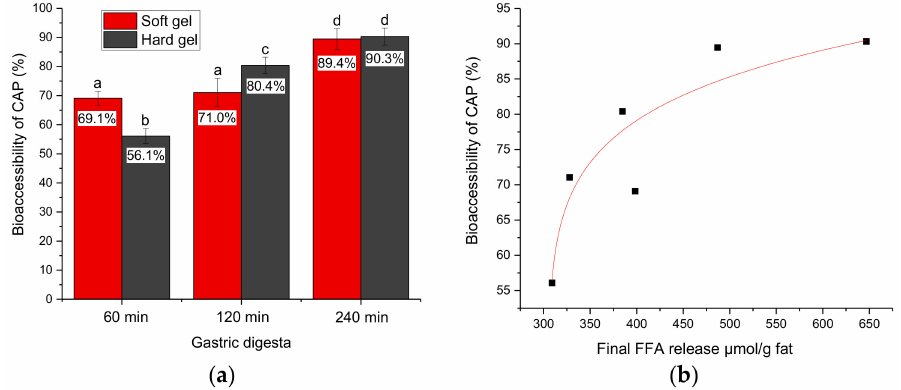
Figure 6. ( a ) Bioaccessibility of capsaicinoids (CAP) after in vitro gastrointestinal digestion. Error bars represent standard deviations obtained from three replicates. ( b ) Correlation be- tween the bioaccessibility of CAP (Y) and the final free fatty acid (FFA) release per gram of fat (X): Y = 49.2 × (X − 305.3) 0.104 R 2 =